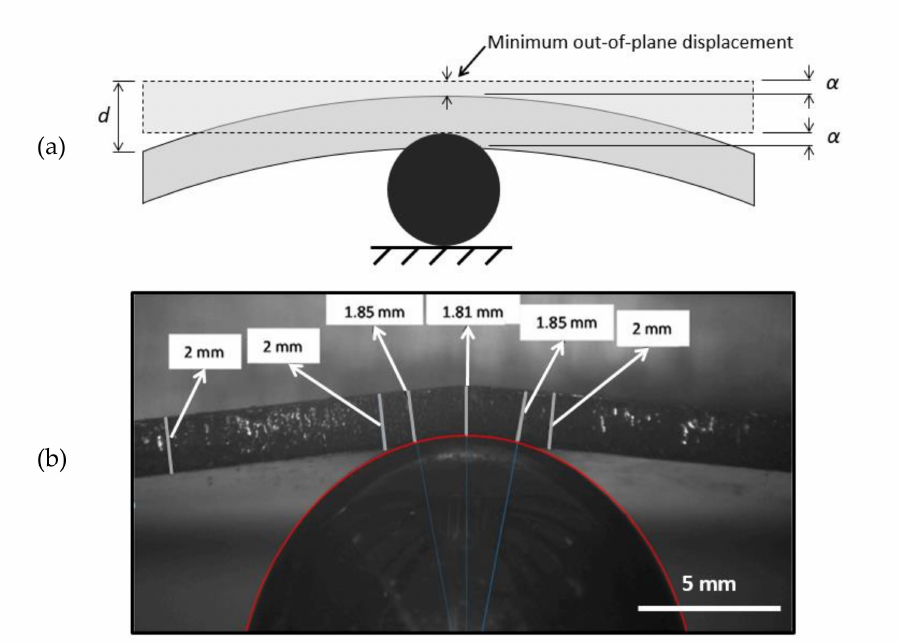
Figure 2. ( a ) Schematic illustration showing the indentation measurement principle during a contact experiment which includes bending. ( b ) Real test illustrating the thickness reduction at the contact area and the indentation